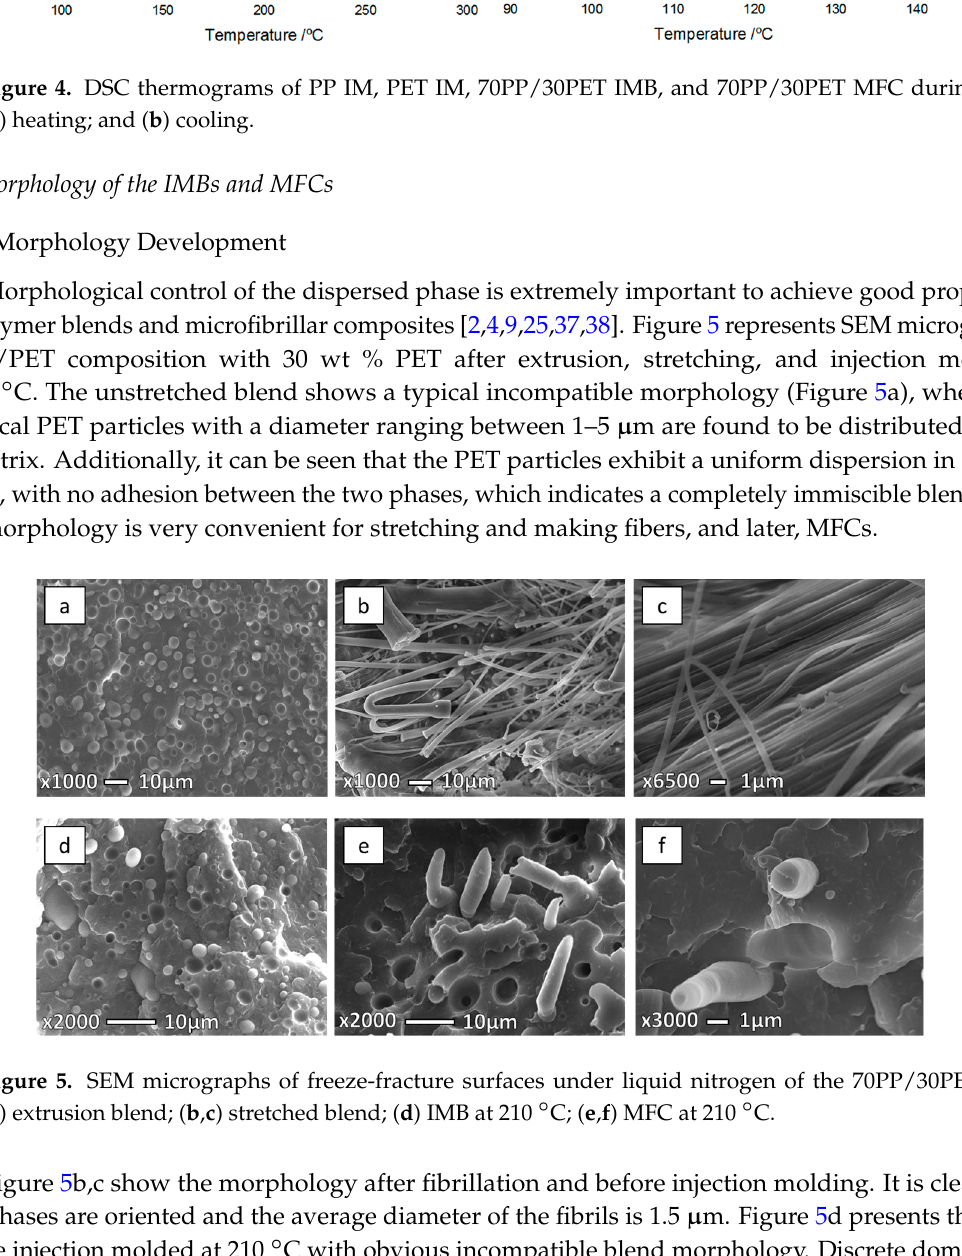
Figure 5. SEM micrographs of freeze-fracture surfaces under liquid nitrogen of the 70PP/30PET ( a ) extrusion blend; ( b , c ) stretched blend; ( d ) IMB at 210 °C; ( e , f ) MFC at 210 °C.